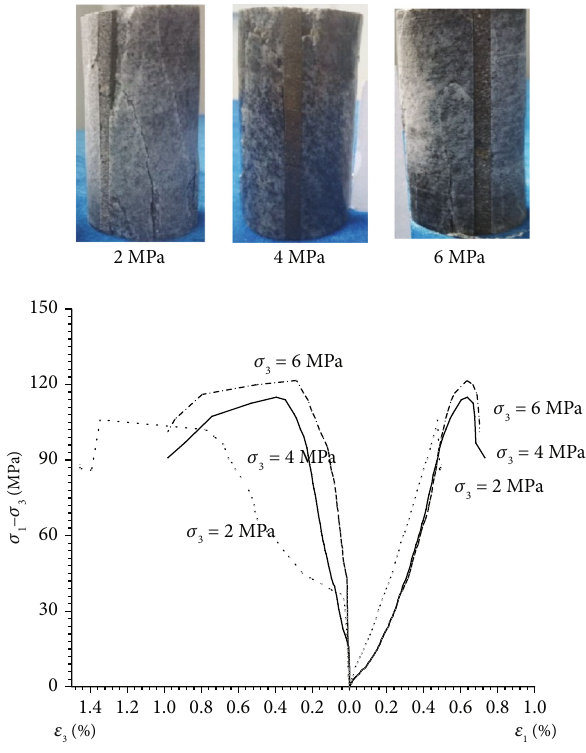
Figure 8: Stress-strain curve and typical failure mode under di ff erent con fi ning